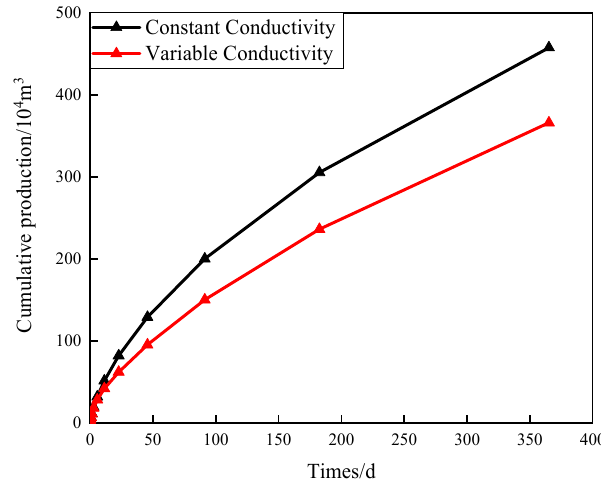
Figure 10. Cumulative production (constant conductivity vs. variable conductivity).